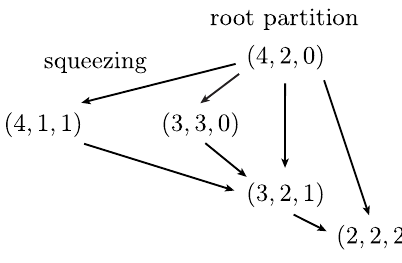
Figure 6: Directed graph formed by subsequent squeezing of a root partition λ = ( 4,2,0 ) . The resulting partitions determine which monomials are featured in − 1 / 2 Jack J ( 4,2,0 )